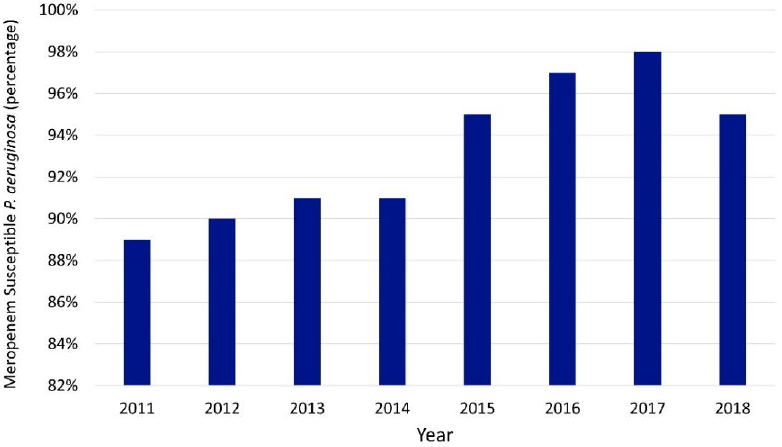
Figure 3. Meropenem susceptibility over time. Susceptibility changes were significant between years ( p = 0.001 via chi-squared) . ( p = 0.001 via chi-squared).